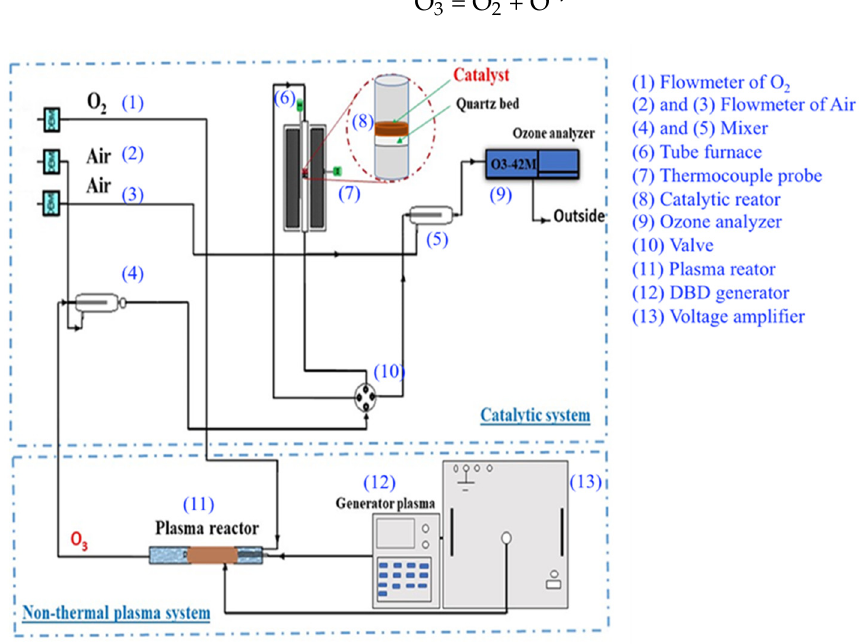
Figure 9. Experimental setup to decompose O 3 at 25 °C.